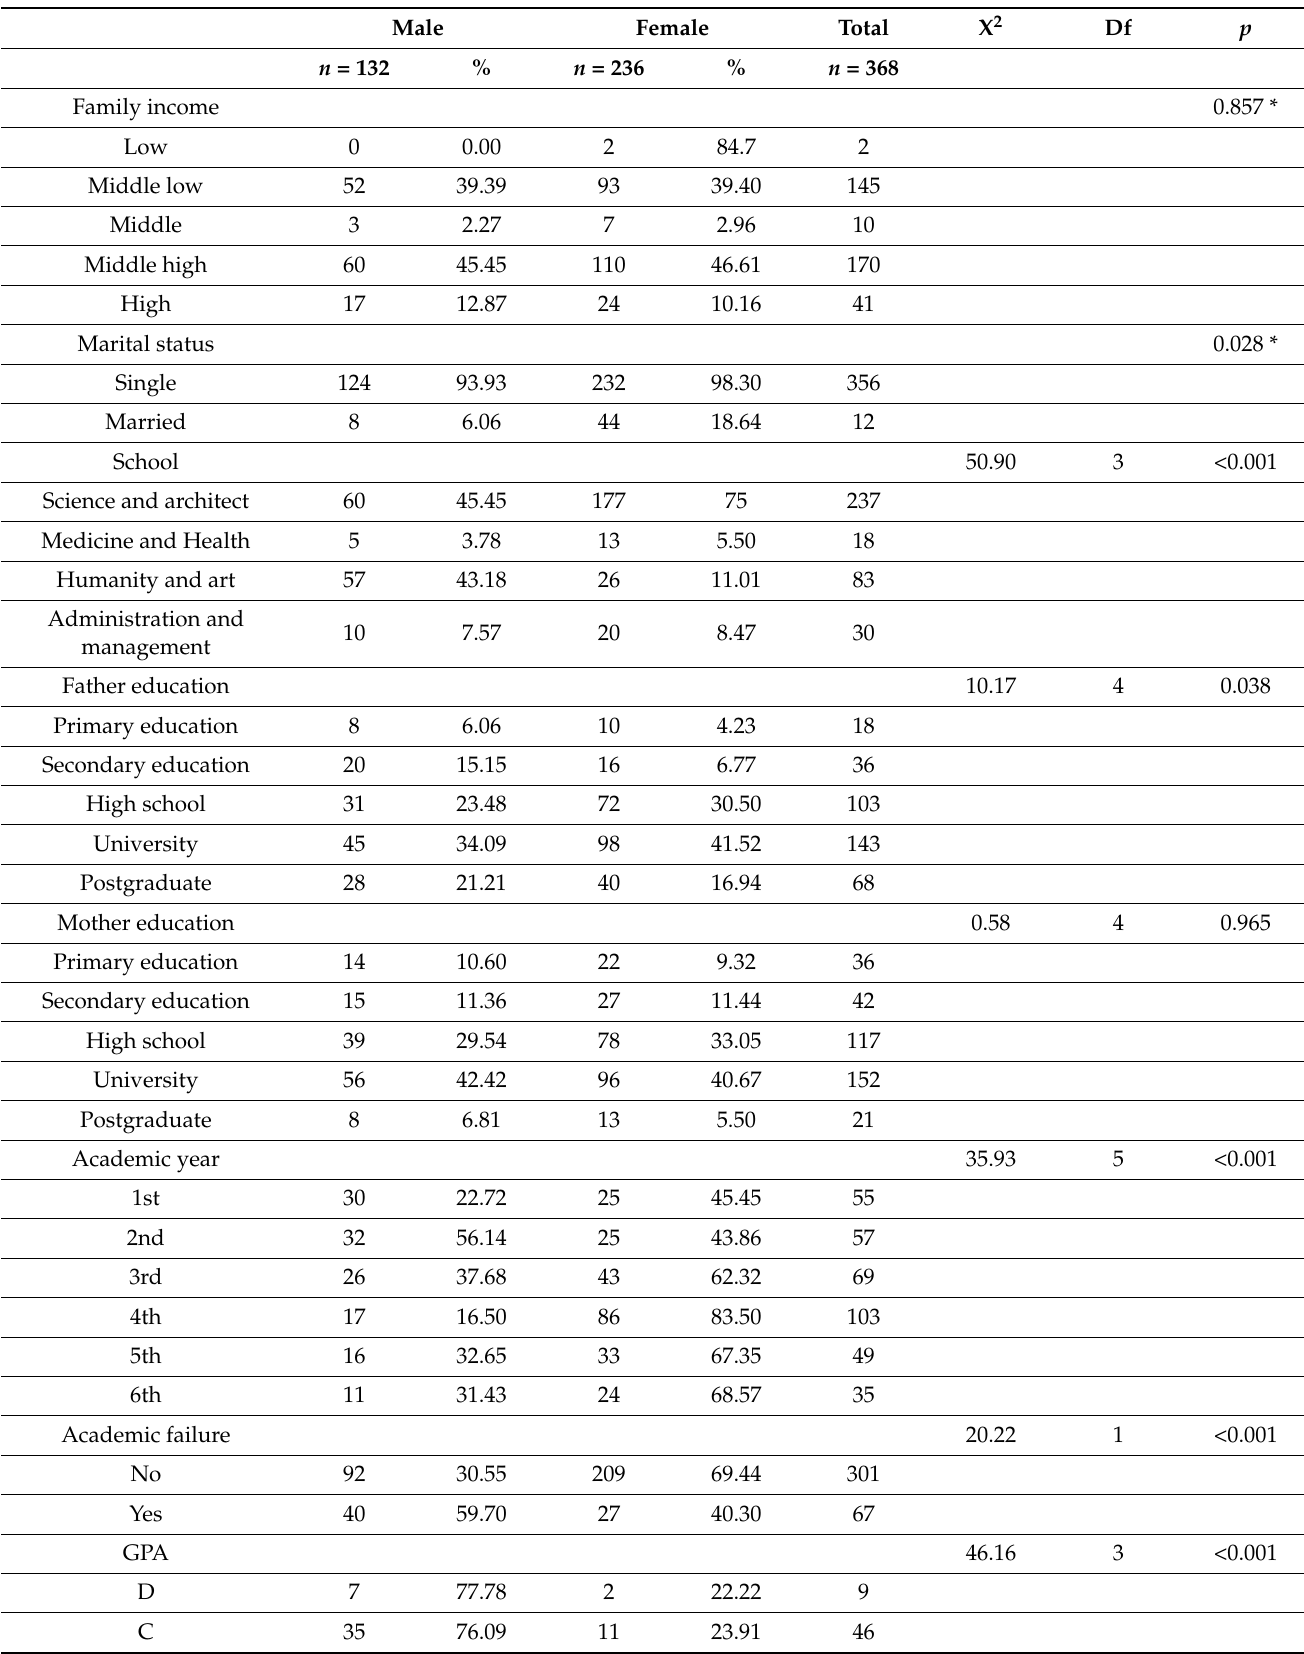
Table 1. The distribution of sociodemographic features of the study participants in relation to